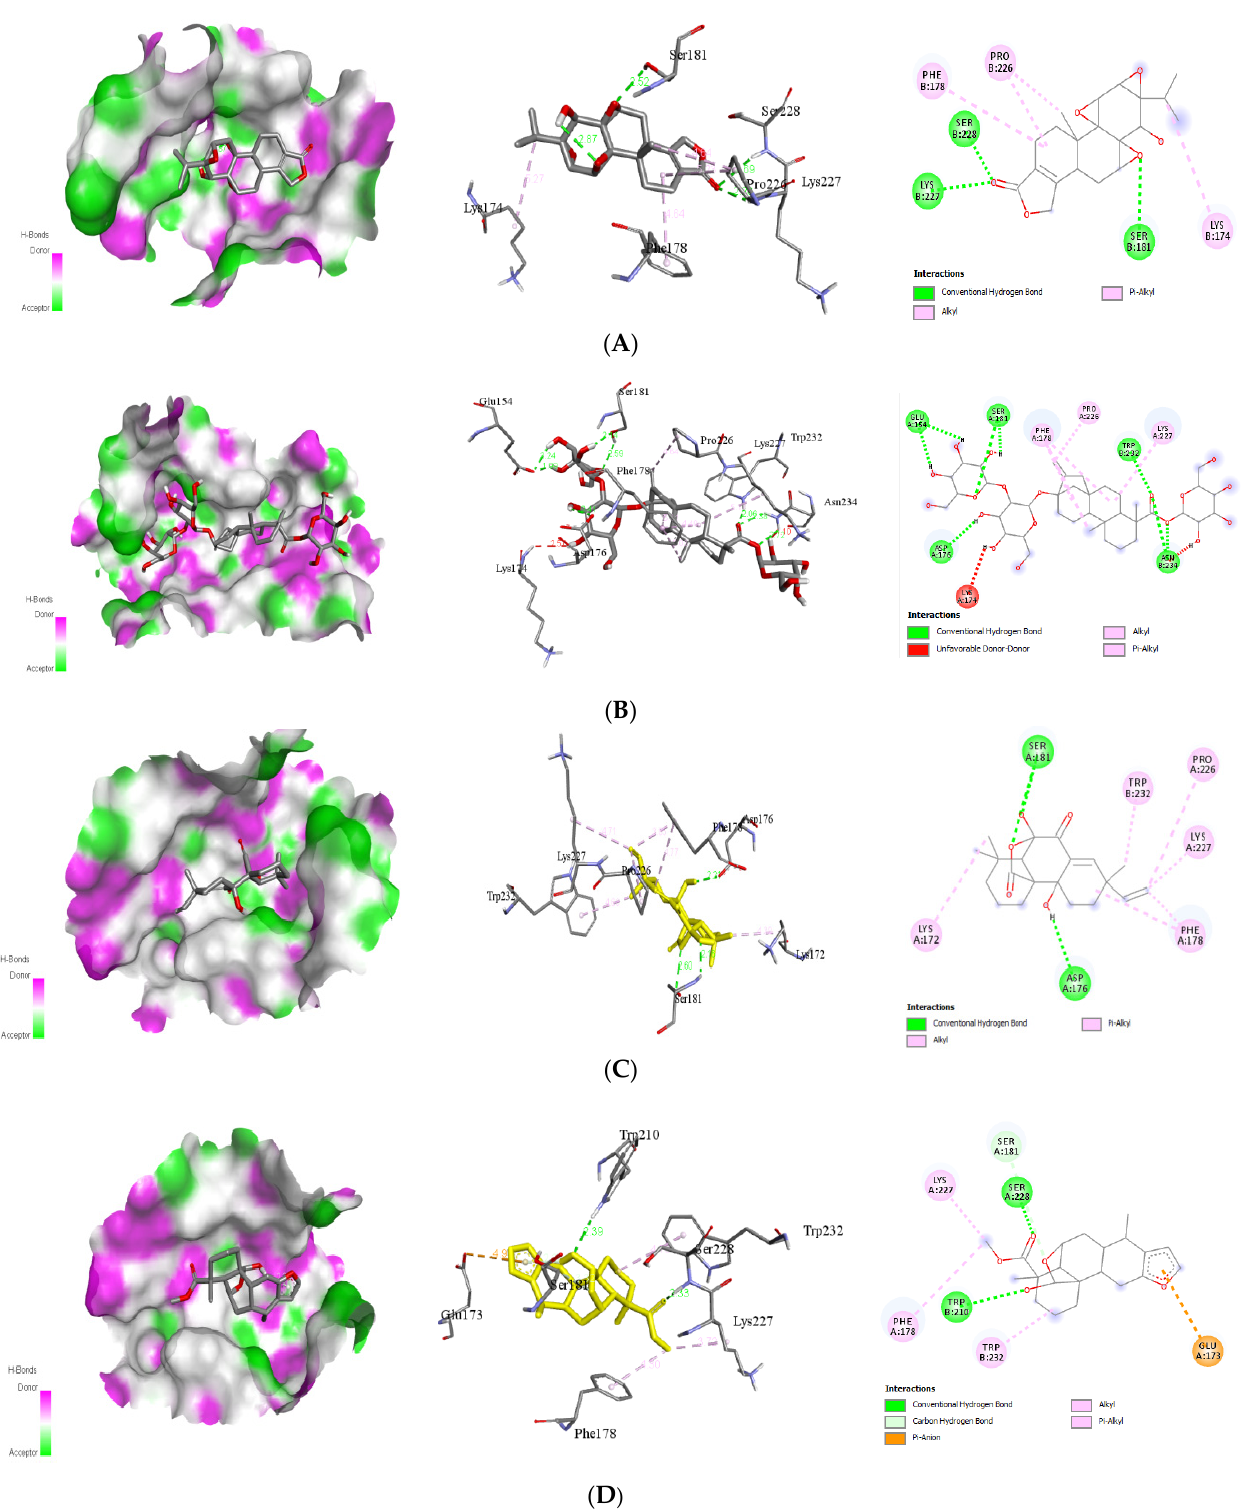
Figure 6. Binding poses of four top-ranked compounds at the binding site of dengue virus NS1 (PDB ID: 4O6B) and 2D and 3D interaction diagrams. ( A ) Triptolide-NS1; ( B ) stevioside-NS1; ( C )sphaeropsidin A-NS1; ( D ) caesalacetal-NS1.